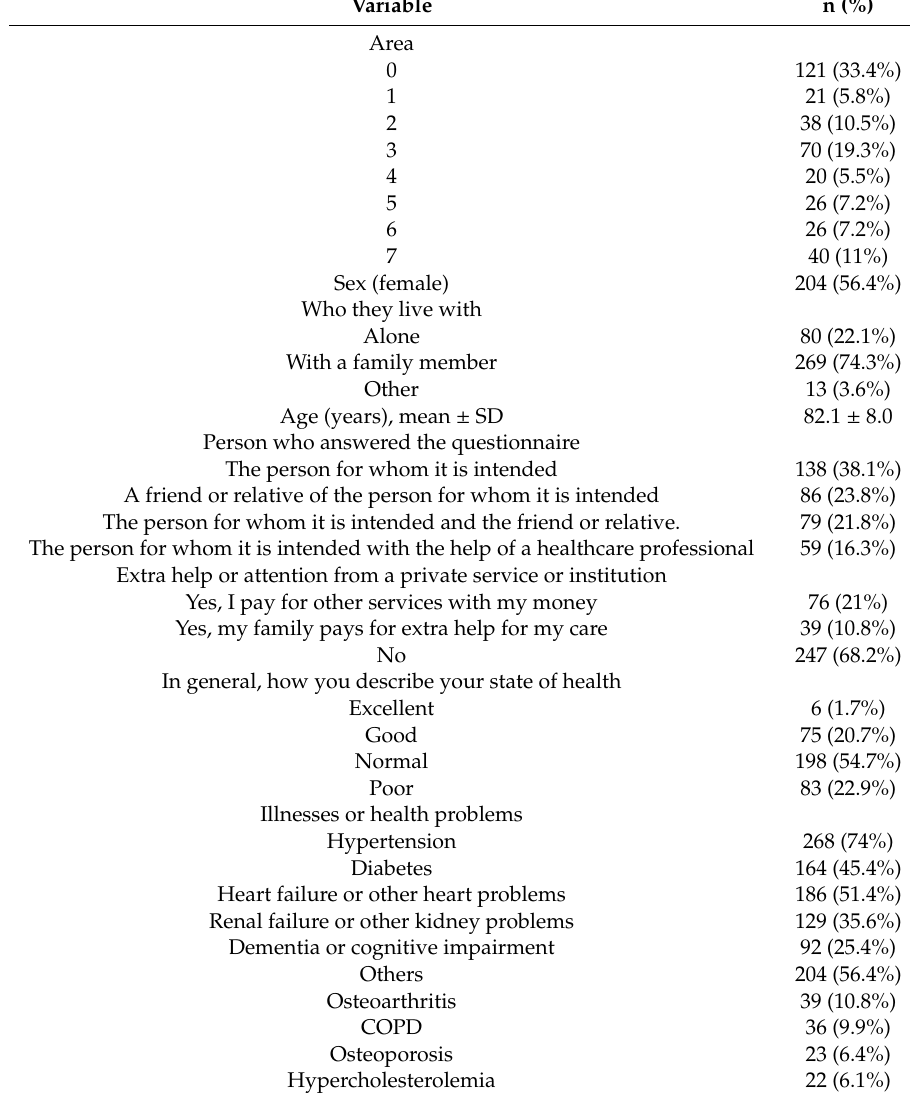
Table 1. Sample characteristics (n =